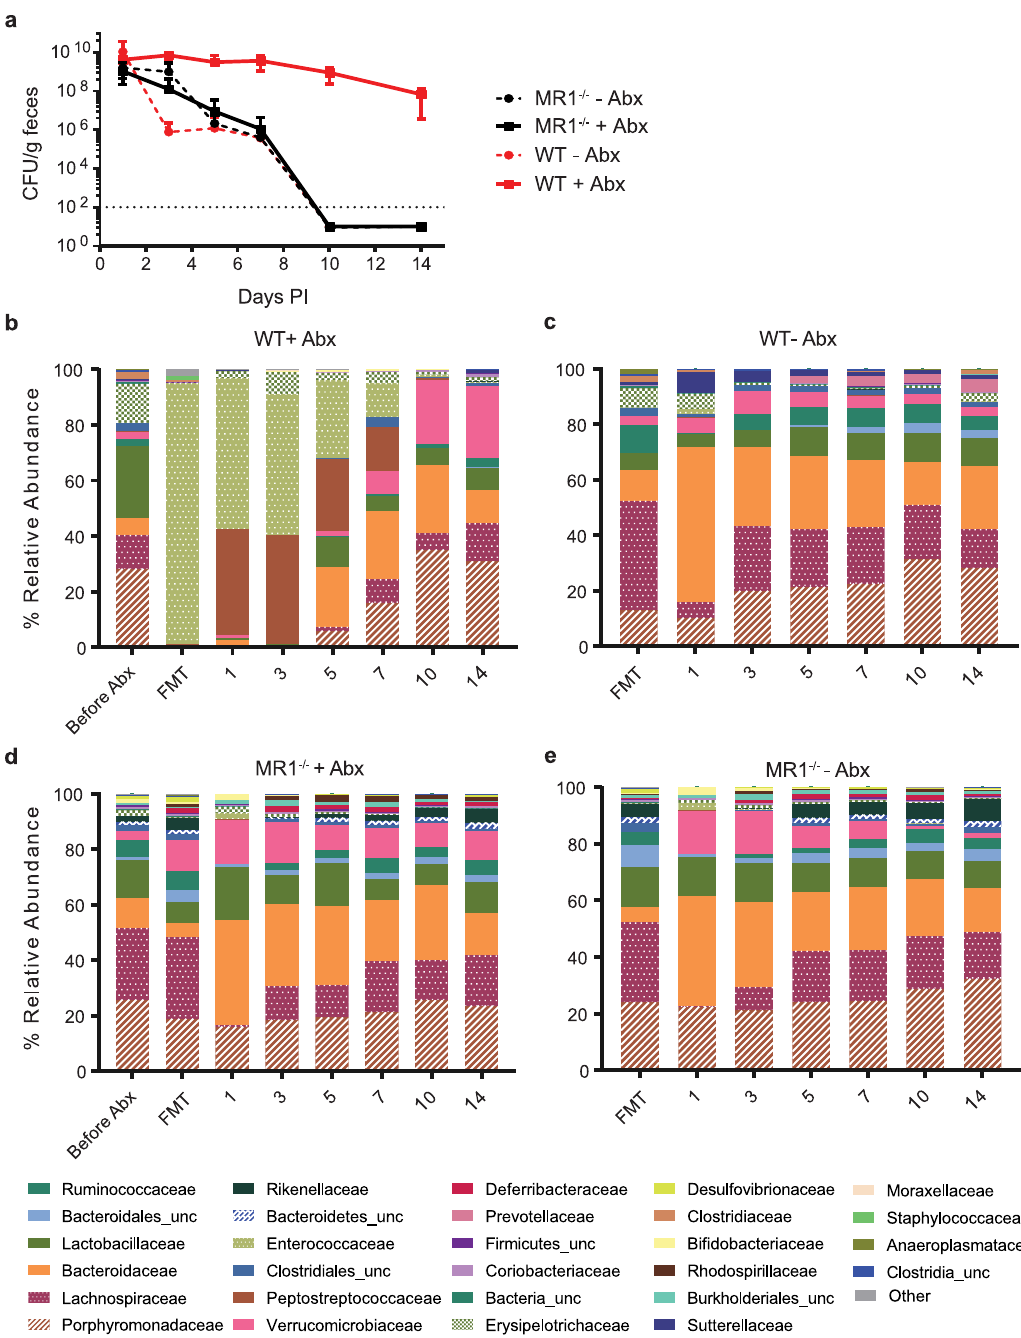
Fig 8. Microbiota of MR1 -/- mice is responsible for colonization resistance. (A) Germ-free C57BL/6NTac mice received FMT from SPF mice. Each donor (SPF WT and MR1 -/- ) strain was separated into two groups, with and without antibiotic treatment. Colonization levels for each group were determined up to 14 days PI. (B-E) Microbial composition of previously germ-free mice following FMT. Data shown are mean ± SD of 2 independent experiments. n = 10 mice per group.